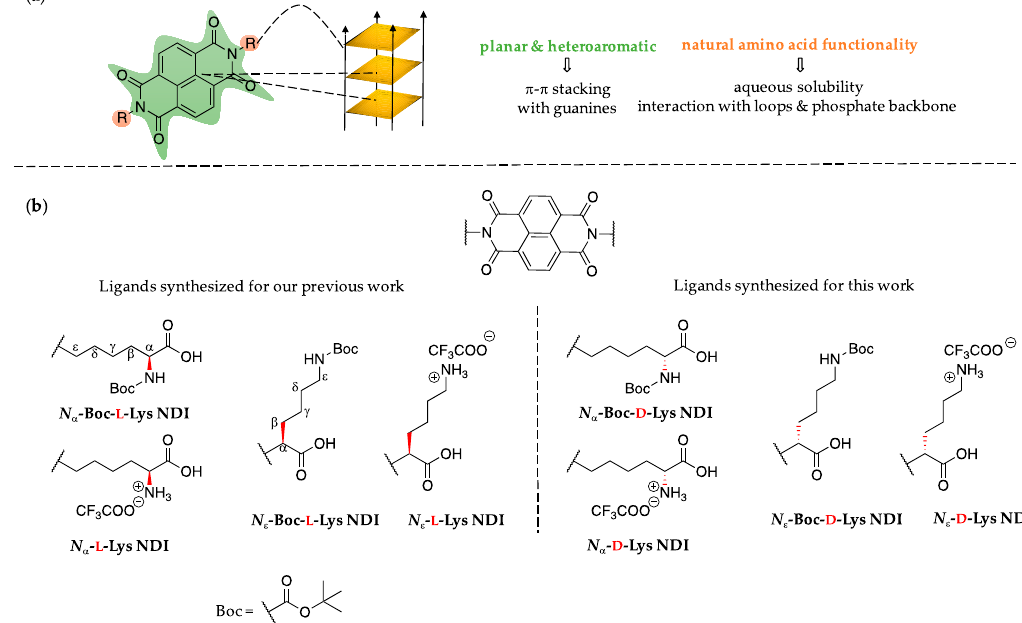
Figure 2. ( a ) Structural features of naphthalenediimide (NDI) molecules synthesized and interaction with G4 DNA; ( b ) chemical structures of L -NDIs (left) and D -NDIs (right) used in our studies and their corresponding names. The naming is based on the position of the carboxylic acid relative to the NDI core: either distal ( N α -Lys NDIs) or proximal ( N ε -Lys NDIs). The L or D chirality is highlighted in red.